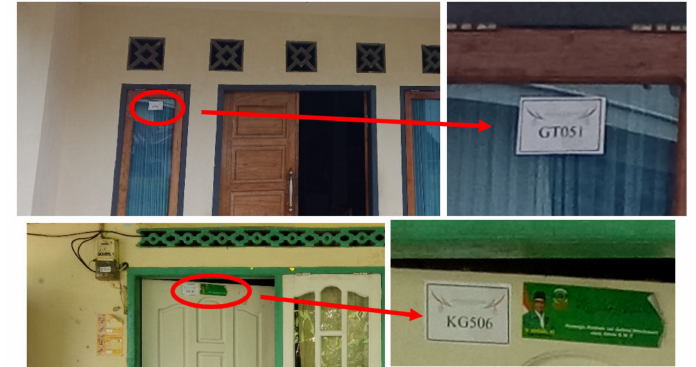
Figure 6. Markers of buildings where attribute data were